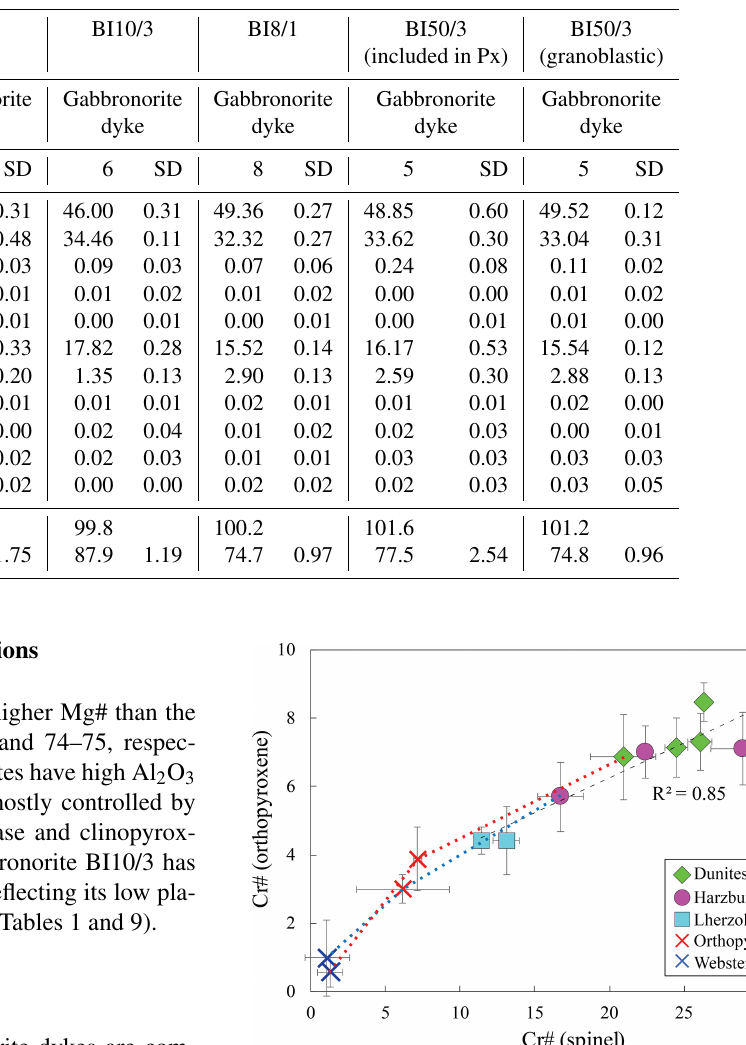
Table 7. Chemical compositions of plagioclase from selected samples. An = molar proportion of anorthite component [100 × Ca /( Ca + K + Na ) , in atoms per formula unit].